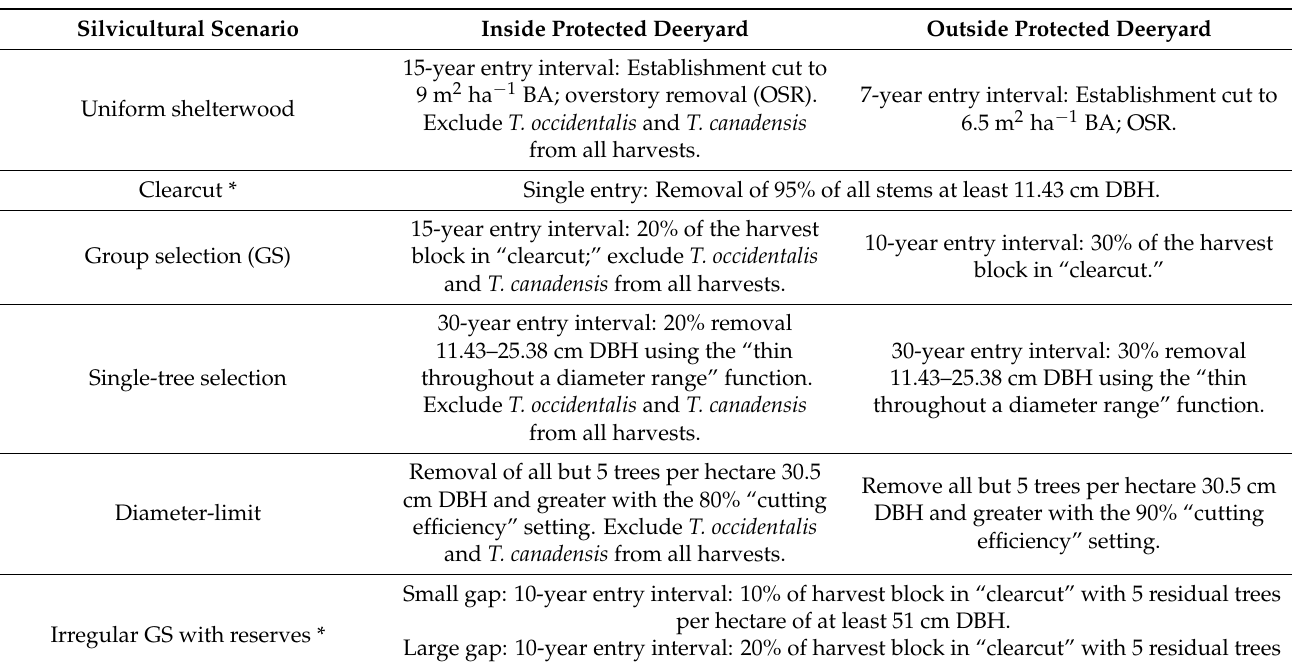
Table 1. Silvicultural scenarios and parameters for growth-and-yield modeling using the Forest Vegetation Simulator (FVS) inside and outside protected deeryards (PDs) in Maine. The scenarios were adapted to FVS functions and settings from actual silvicultural activities described by professional foresters in Maine. OSR indicates overstory removal timber harvest; DBH is the diameter at breast